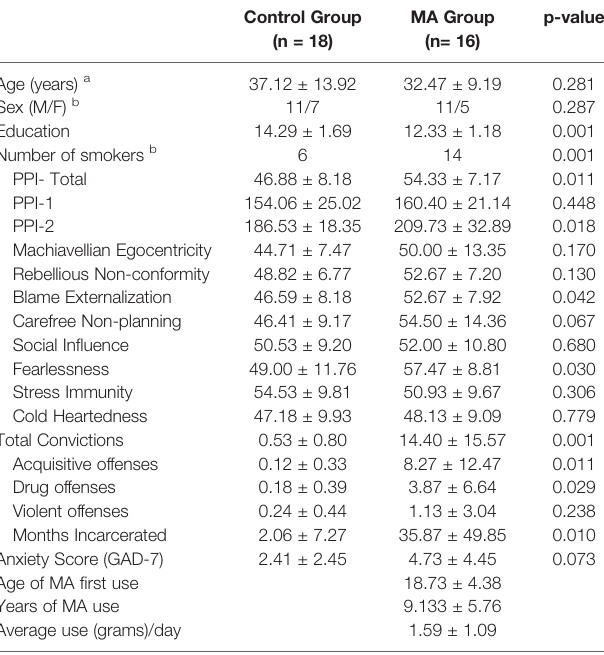
TABLE 1 | Participant characteristics included in imaging